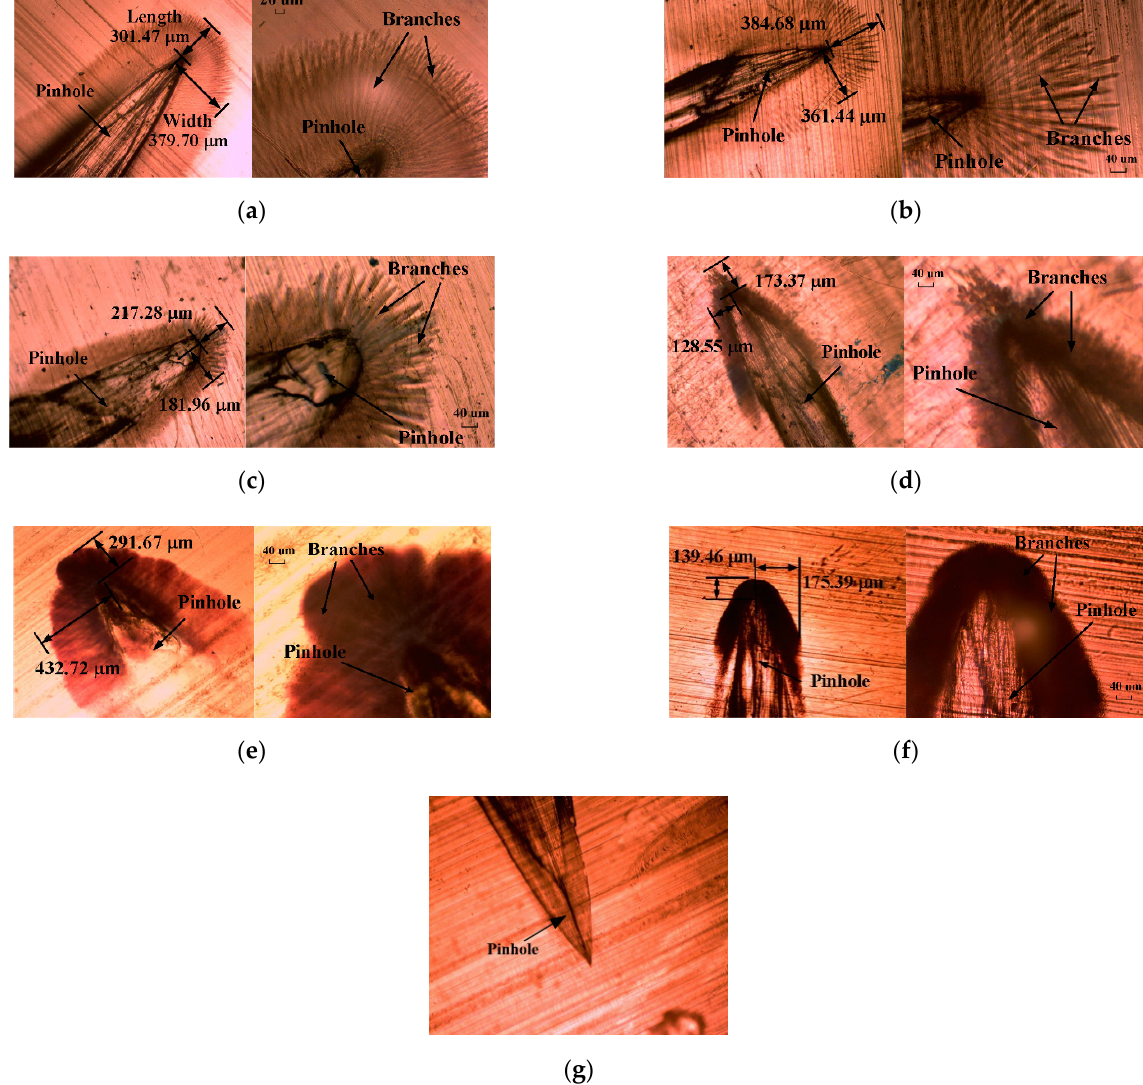
Figure 4. Water tree morphologies at different temperatures after 22 days of aging (24 h per day): ( a ) − 15 °C; ( b ) 0 °C; ( c ) 20 °C; ( d ) 40 °C; ( e ) 60 °C; ( f ) 80 °C (×64 and ×160 magnifications); ( g ) pinhole without water tree aging.